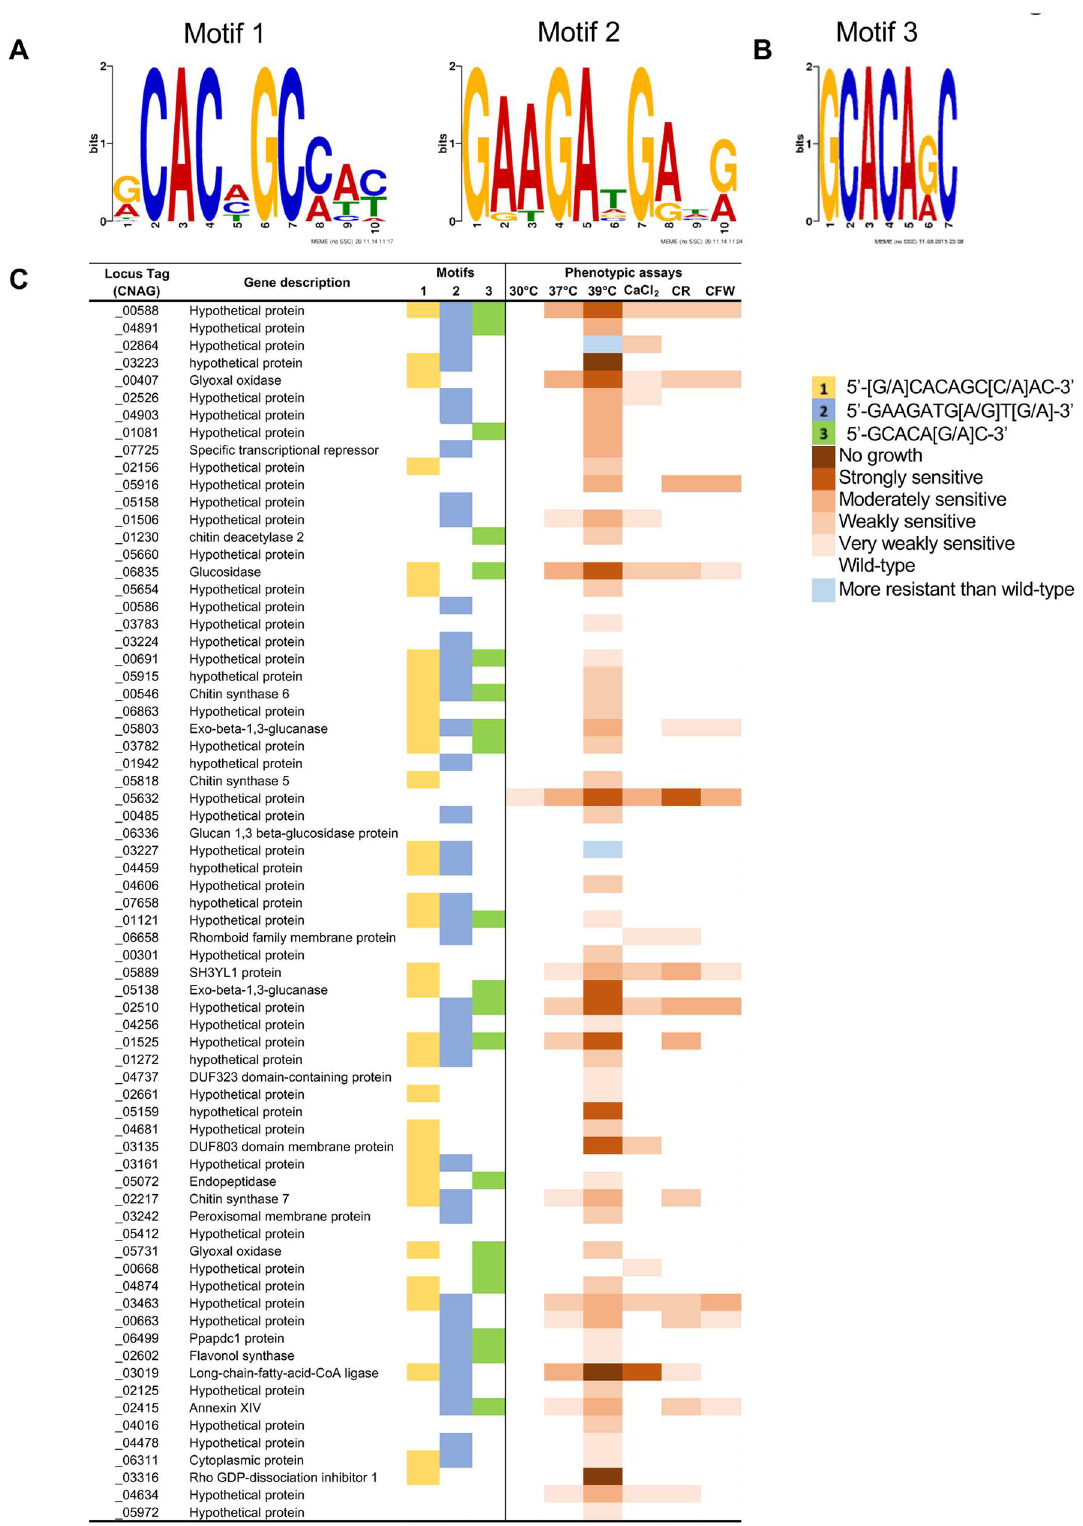
Fig 5. Genes regulated by the calcineurin-Crz1 pathway feature three motifs. (A) DNA motifs generated by MEME from promoter analysisof the 102 target genes. (B) DNA motif generatedby DREME from promoteranalysisof CHS6